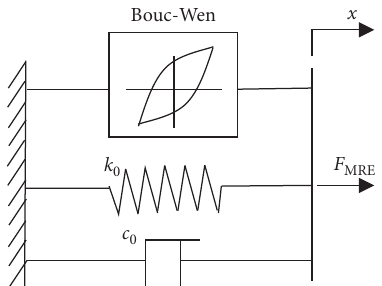
Figure 1: Schematic diagram of MRE-based isolator model.